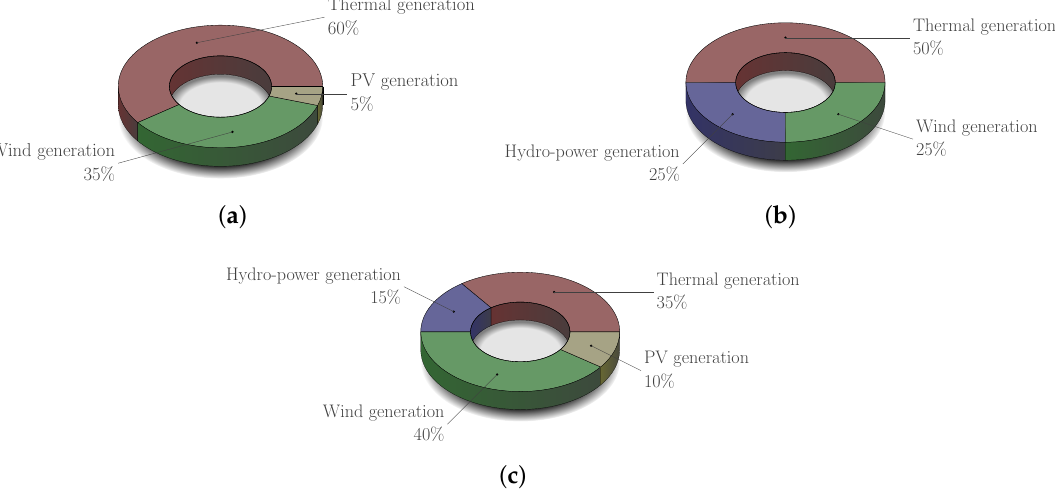
Figure 6. Generation contribution per area. ( a ) Area 1; ( b ) Area 2; ( c ) Area 3.